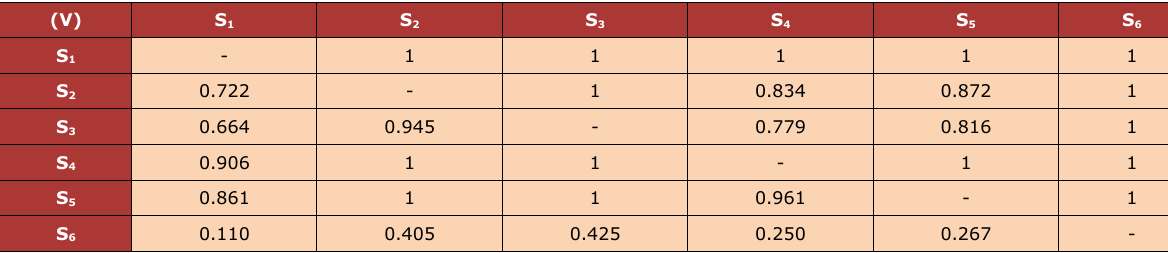
Table 6. V values